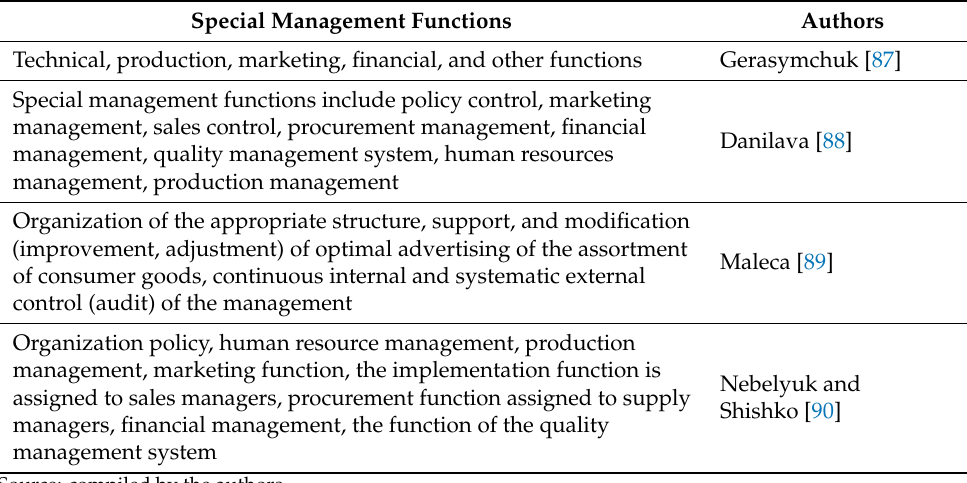
Table 8. Special management